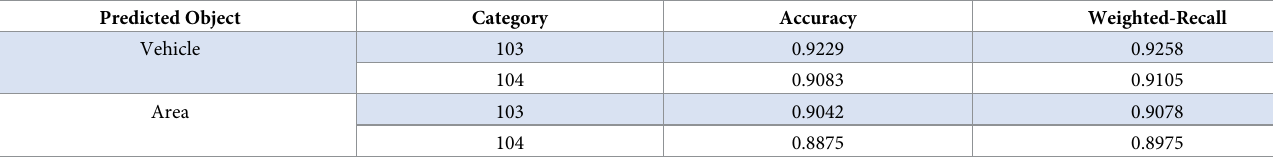
Table 8. Prediction performance for different categories of distracted driving